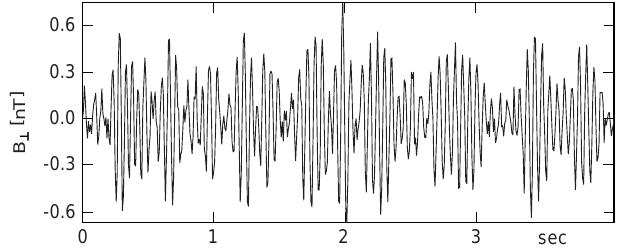
Fig. 1. Lion roar waveform perpendicular to the mean field